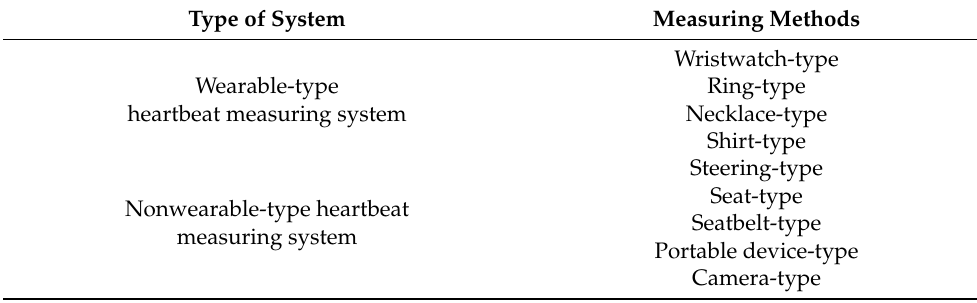
Table 2. Wearable and nonwearable